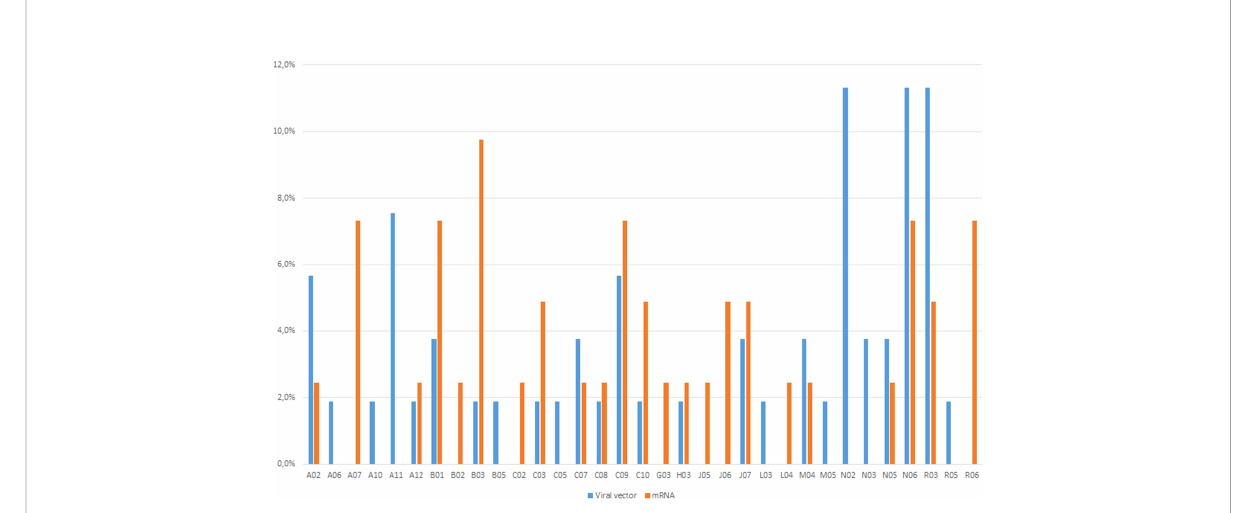
FIGURE 2 Distribution of other concomitant drugs reported in the ICSR related to mRNA- and viral vector-based COVID-19